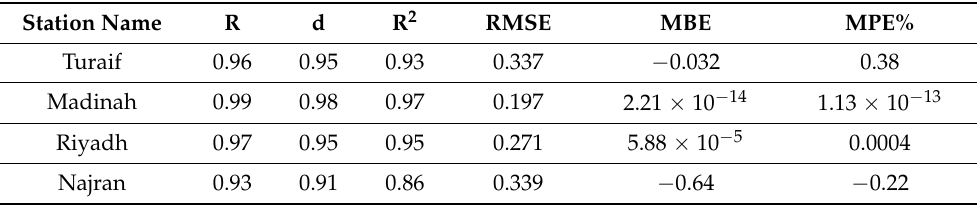
Table 5. R, R 2 , d, RMSE, MBE and MPE% for the Winter Air Temperatures between ERA-5 reanalysis data and observed data at the selected four stations in Saudi Arabia.